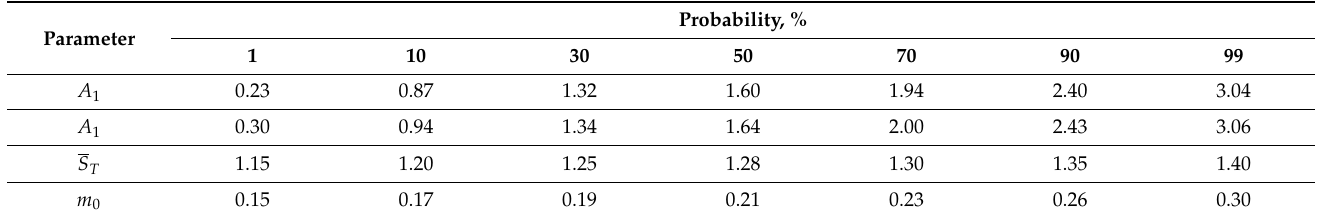
Table A5. Probabilistic values of parameters of cyclic deformation resistance for steel 15Cr2MoVA.